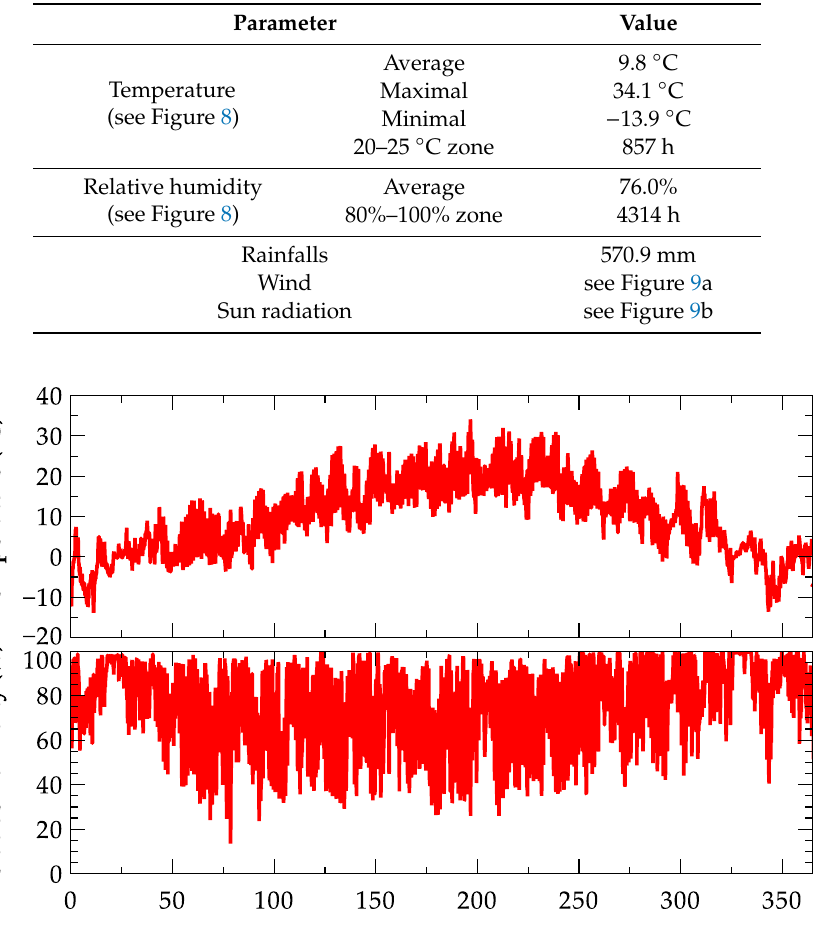
Table 2. Summary of weather parameters, Olomouc, Czech Republic.